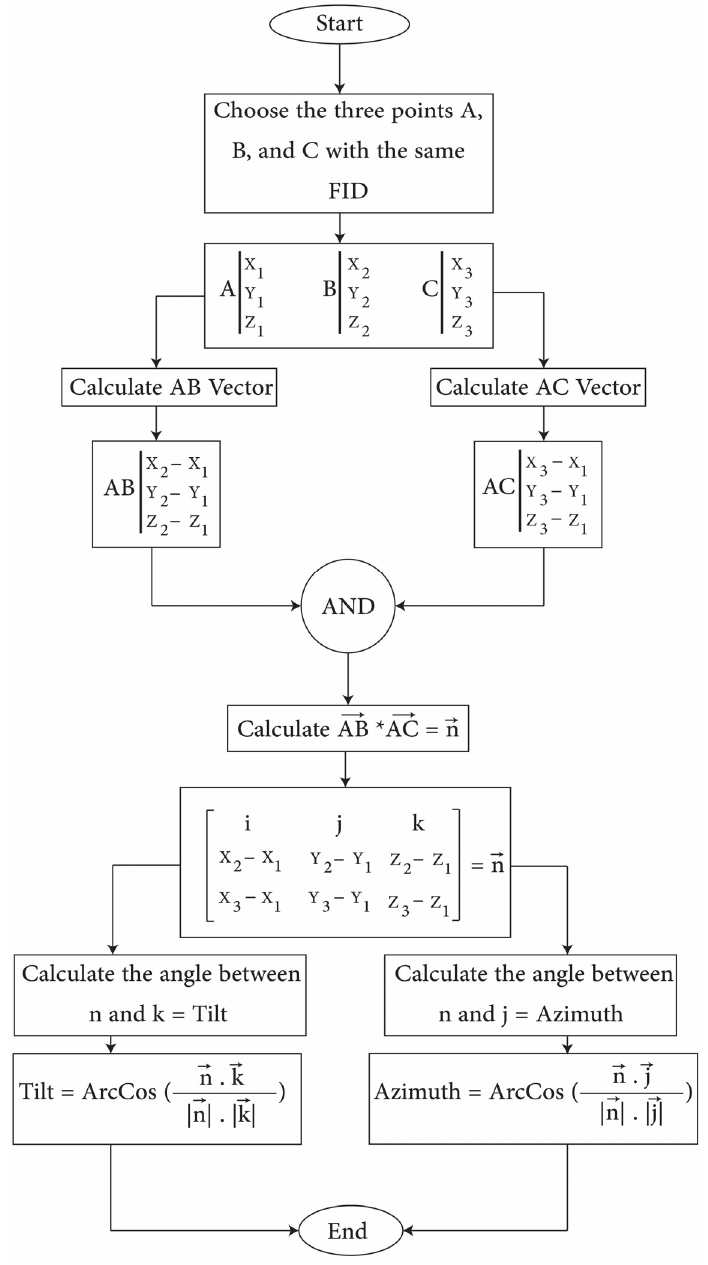
Figure 3. Flowchart of tilt and azimuth angles calculation [34].